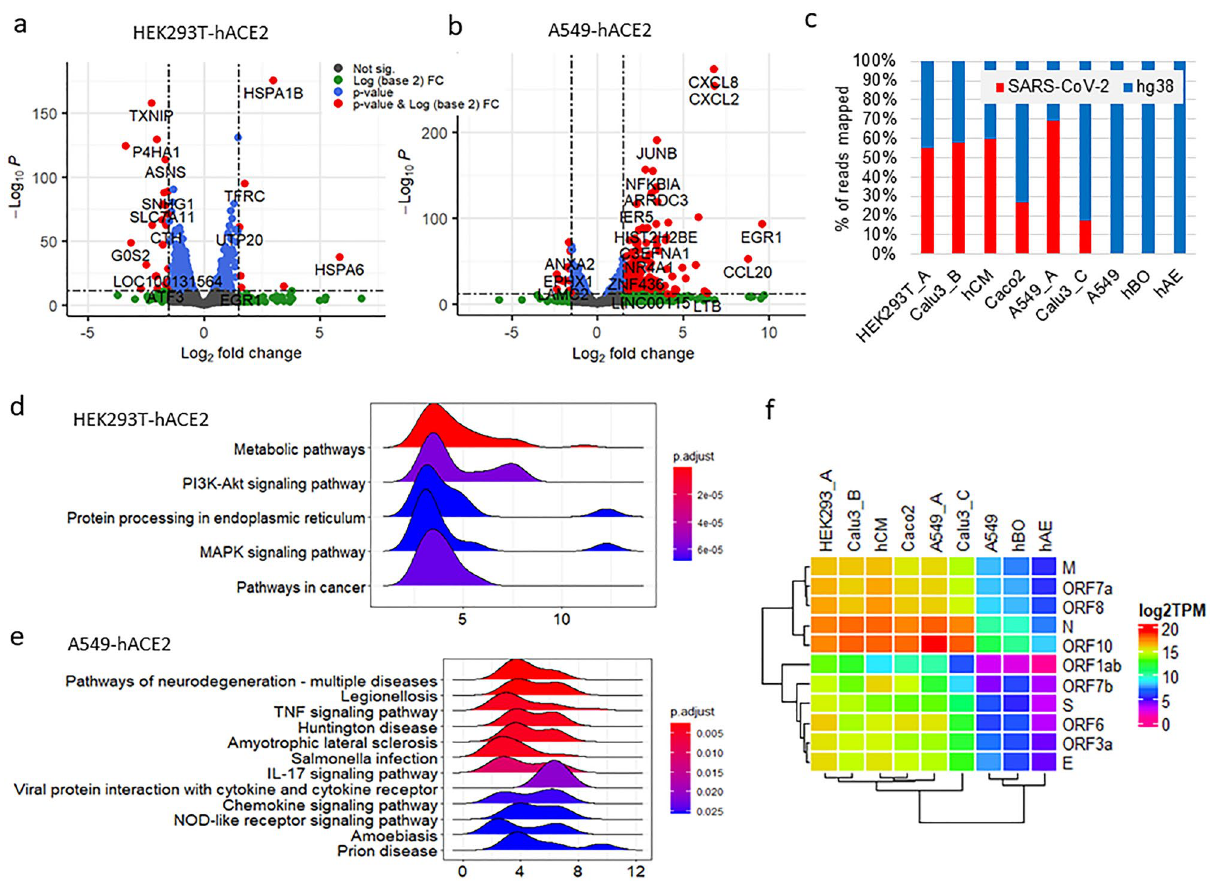
Figure 2. The transcriptome of SARS-CoV-2 infection in HEK293T-hACE2 cells. ( a ) Volcano Plot of DEGs of SARS-CoV-2 infection in HEK293T-hACE2 cells. ( b ) Volcano Plot of DEGs of SARS-CoV-2 infection in A549- hACE2 cells. ( c ) Percentage of reads mapped to SARS-COV-2 genome and human hg38 genome from the nine RNAseq datasets of SARS-COV-2 infection in cell lines used in this study. ( d ) Major KEGG pathways enriched with DEGs of SARS-CoV-2 infection in HEK293T-hACE2. ( e ) Major KEGG pathways enriched with DEGs of SARS-CoV-2 infection in A549-hACE2. ( f ) Heatmap of SARS-CoV-2 gene expression SARS-CoV-2 infected cells by transcripts per million (TMP). HEK293T_A and A549_A represent HEK293T or A549 with hACE2 overexpression, respectively. Calu3_B and Calu3_C represent data from the RNAseq data by Wyler E. (bioRxiv) and Blanco-Melo D. (Cell),